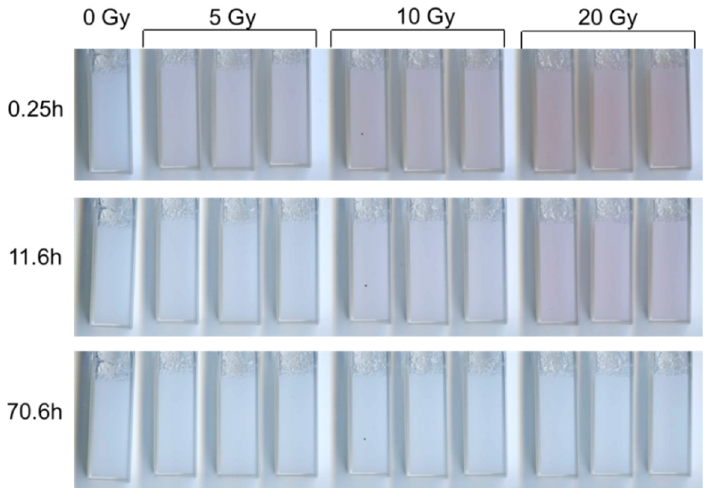
Figure 2. Scanned images of PAISiN stored at 20 °C taken at 0.25 h ( upper ), 11.6 h ( middle ) and 70.6 h ( lower ) after 137 Cs γ -ray irradiation.